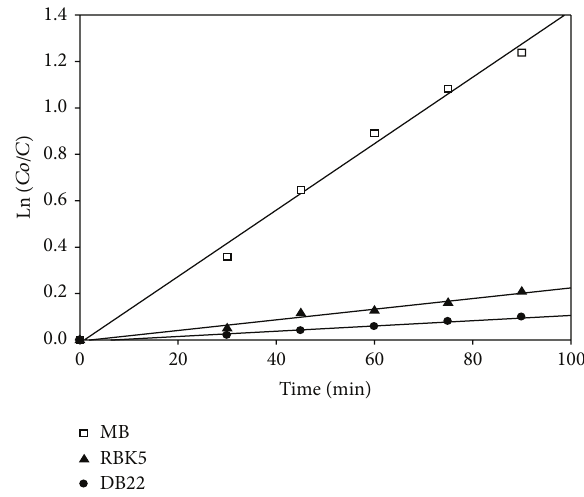
Figure 8: The effect of Fe content on degradation efficiency under 254 nm UV and catalysts loading of 0.04gL −1 .